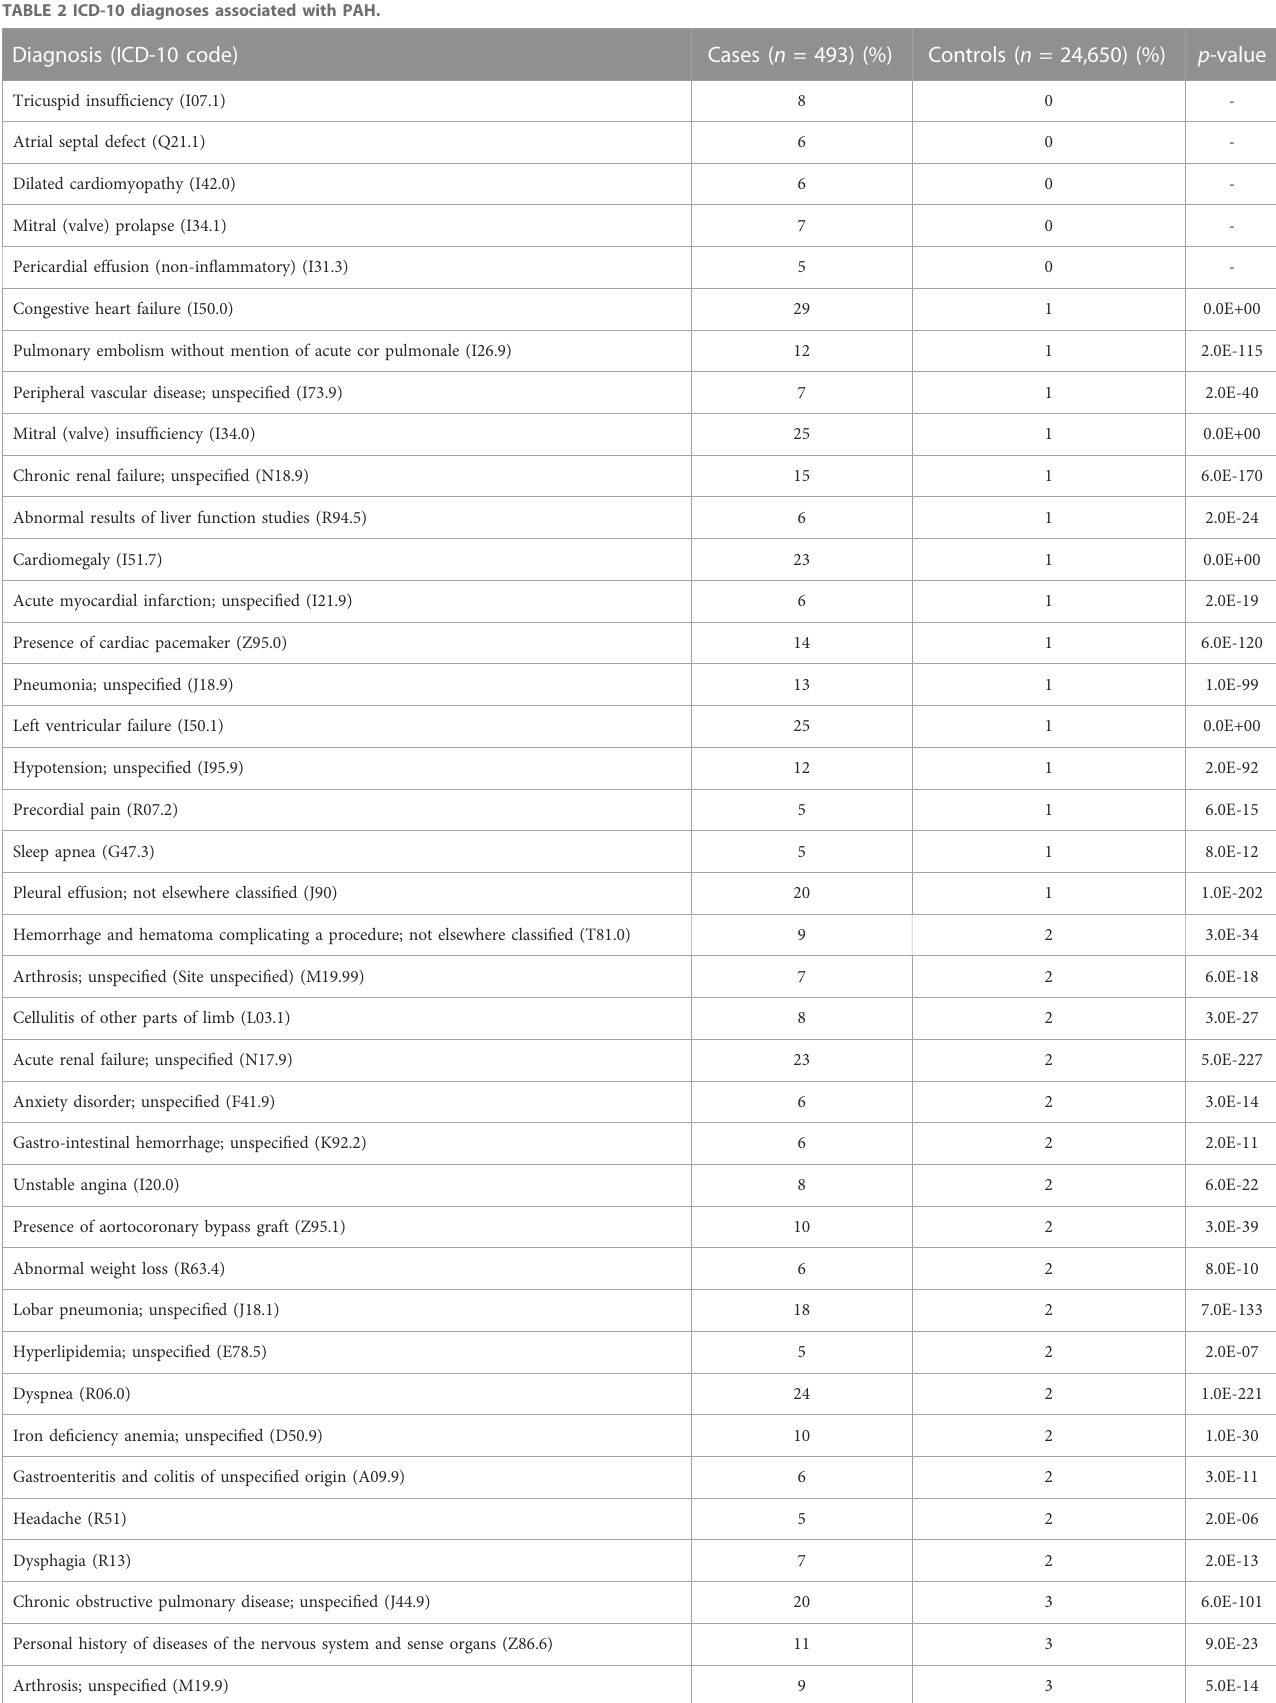
TABLE 2 ICD-10 diagnoses associated with